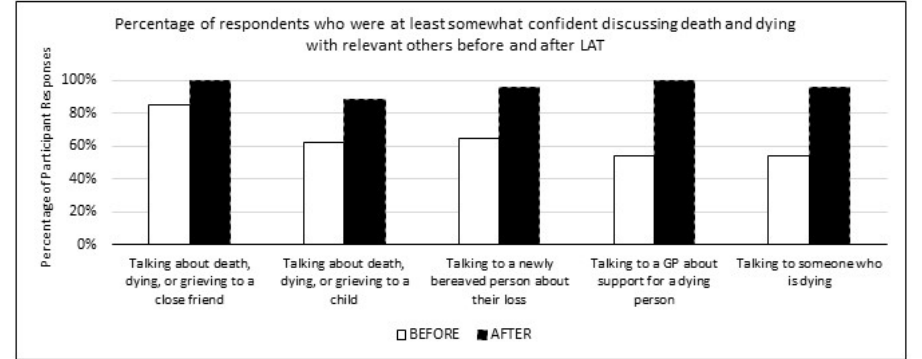
Figure 2. Confident Conversations on Death and Dying.